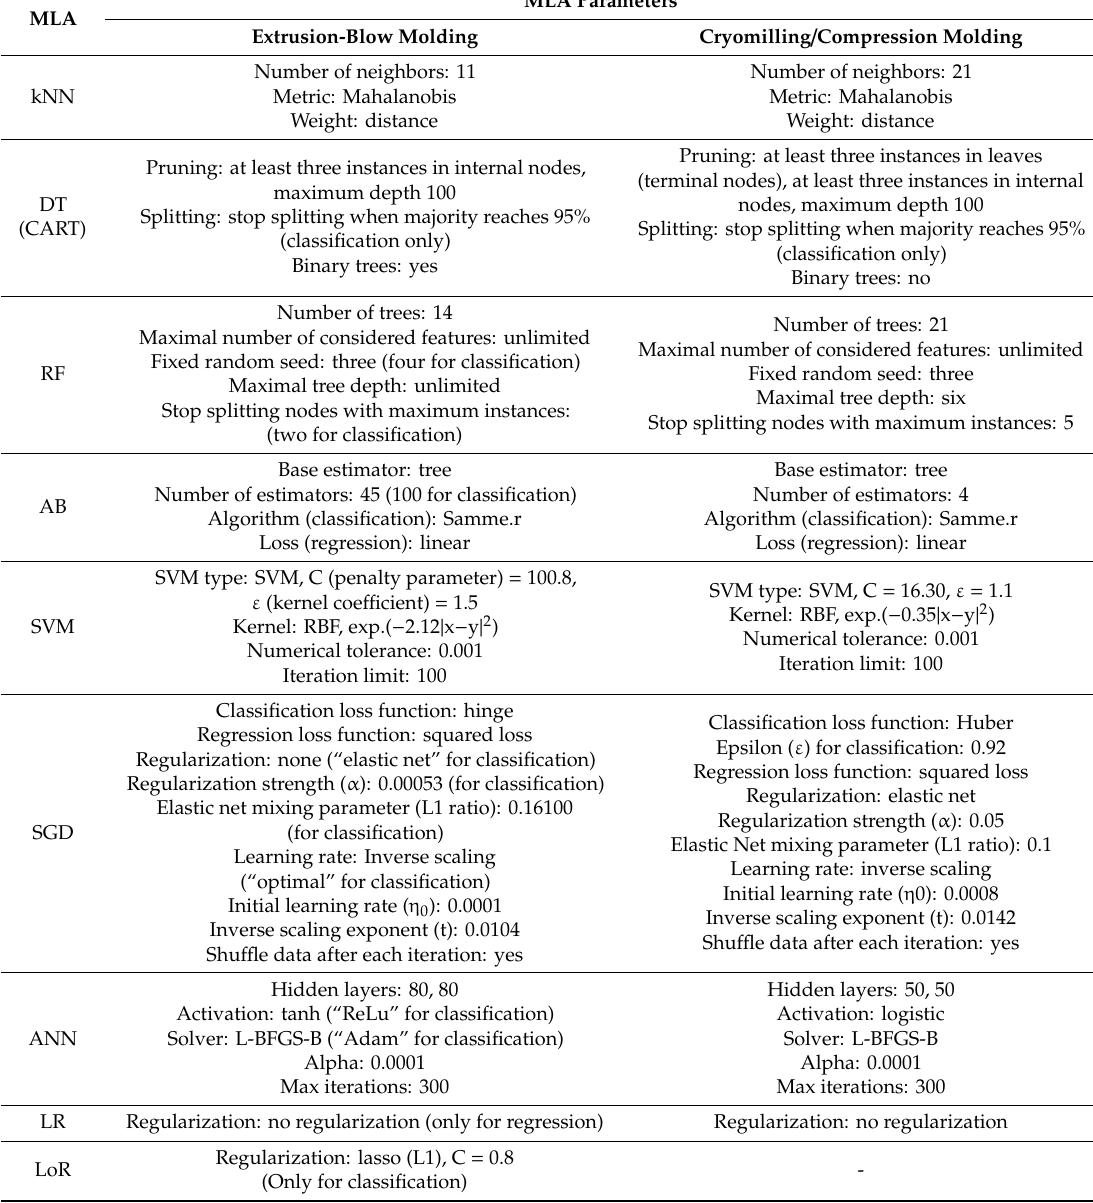
Table 3. Selected machine learning algorithm (MLA)